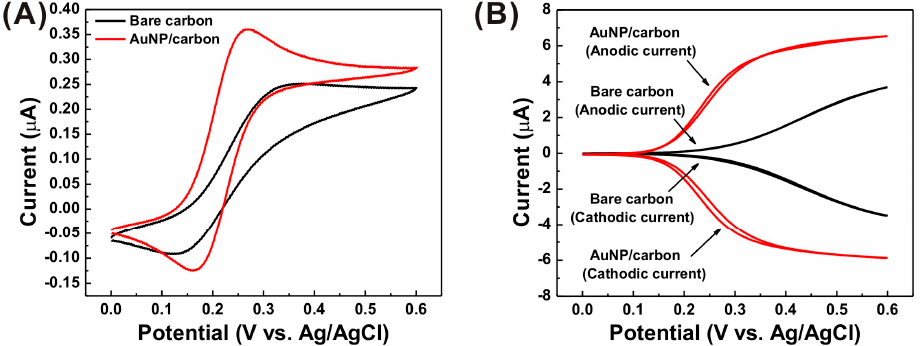
Figure 3. Cyclic voltammograms of the bare carbon IDEs and AuNP/carbon IDEs in 10 mM [Fe(CN) 6 ] 4- with 0.1 M KCl in ( A ) the single mode (without redox cycling) and ( B ) the dual mode (with redox cycling).